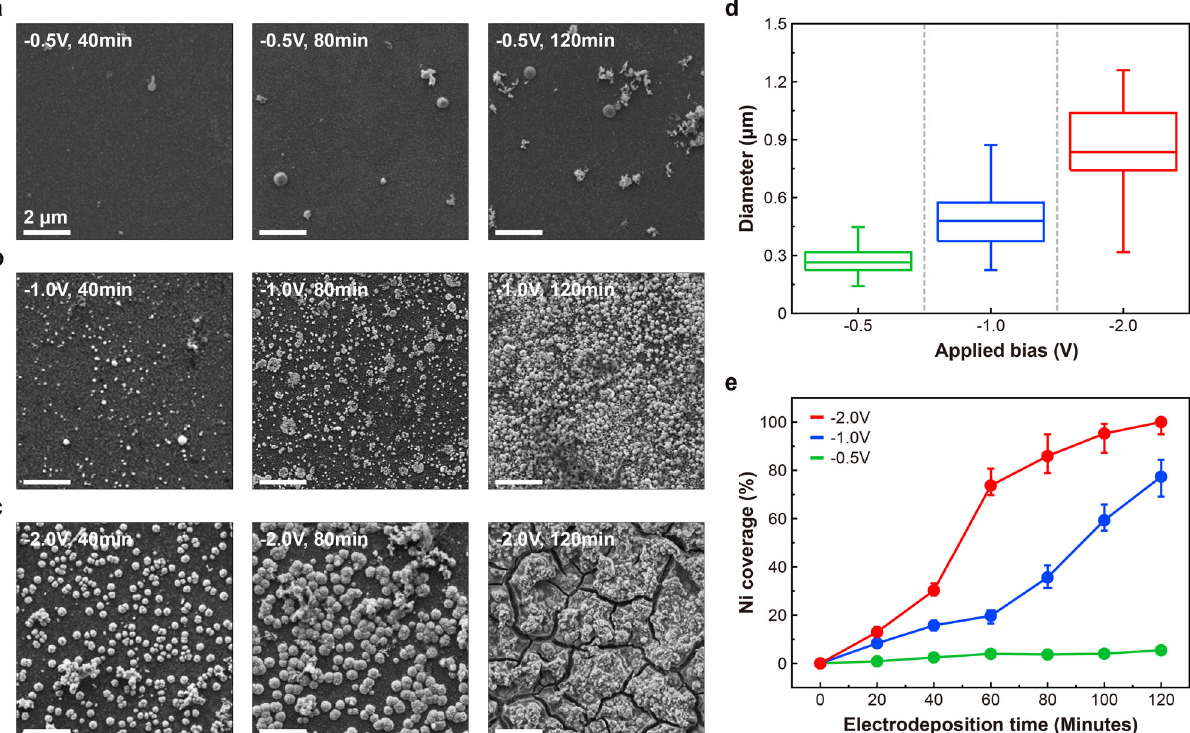
Fig. 3 Characterization of Ni electrodeposition. a – c SEM images of Ni electrodeposited into voids created within a 90 nm SiO 2 layer on an n-type Si substrate via thin- fi lm reaction with Al, for electrodeposition bias voltages of -0.5 ( a ), − 1.0 ( b ), and − 2.0 V ( c ) and for the electrodeposition times of 40, 80, and 120 min. All inset scale bars are 2 μ m. d The size distribution of Ni nano-islands on the SiO 2 /Si surface after 60 min electrodeposition at applied bias voltages of − 0.5, − 1.0, and − 2.0 V. e Ni coverage on the SiO 2 /Si surface as a function of electrodeposition time, for electrodeposition bias voltages of − 0.5, − 1.0, and − 2.0